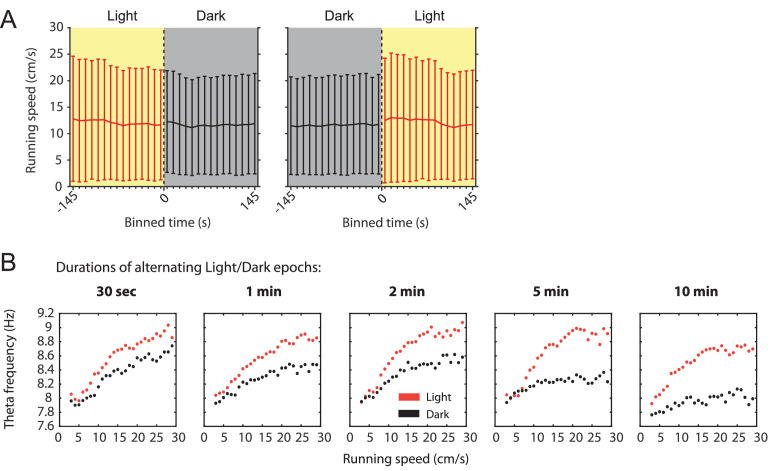
Slow c﻿anges in the local field potential theta frequency to running speed relationship as a function of visual inputs can be observed in a single animal and do not correlate with changes in running speed.(A) Mean running speed as a function of time around the transition points from light to dark or from dark to light plotted in 10 s time bins. Data are shown as mean ± SD across all data points; data from 78 sessions with 3 min alternating epochs of light and dark from 14 mice. (B) Speed tuning curves of local field potential (LFP) theta frequency computed from light (red) or dark (black) epochs of different lengths from the same animal. Note that the gap between speed tuning curves for the light and dark conditions widens with the epochs becoming longer suggesting that speed tuning curves change over time.